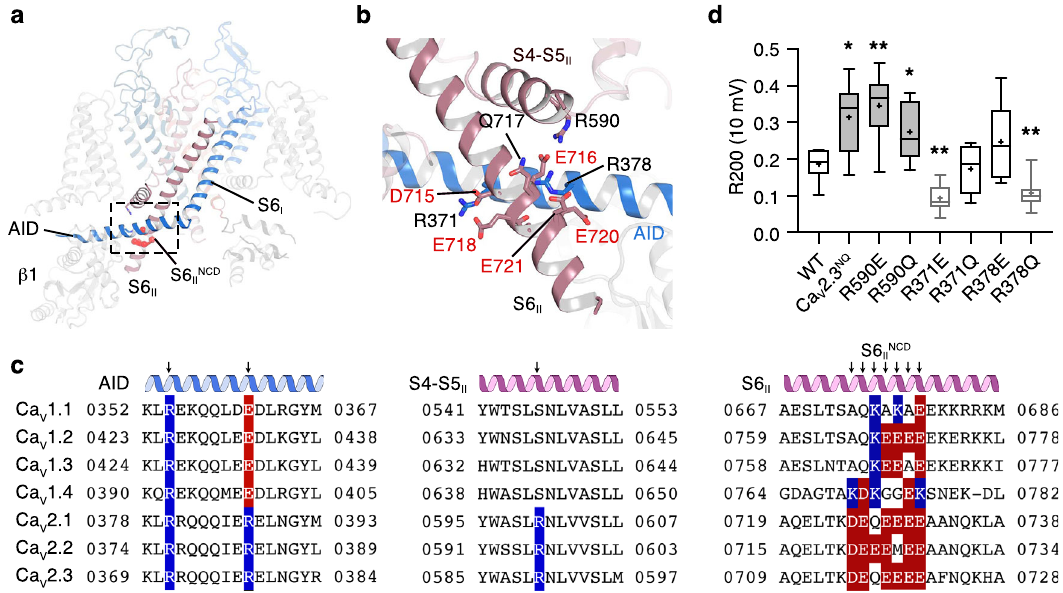
Fig. 5 | Modulation of open-state inactivation. a Interaction of the AID between thenegativelychargeddomainsonS6 II (S6 II NCD )andS4-S5 II .TheCa V 2.3 α 1Esubunit is shownascartoon. The S6 II NCD isoverlaid asredspheres. b Zoomed-inview of the side-chaininteractionsamong S6 II NCD , AID, and S4-S5 II . The S6 II NCD ( 715 DEQEEEE 721 )is shownassticks.ResiduesinvolvedinchargeinteractionsonAIDandS4-S5 II arealso shownassticks.NegativelychargedresidueswithintheS6 II NCD arehighlightedusing red labels. c Sequence alignment of the interaction sites among Ca V 1 and Ca V 2 members. Secondary structures are labeled over the sequences. Mutation sites are indicated by arrows. Residues with positively- and negatively charged sidechains are highlighted by blue and red, respectively. d Ratio of open-state inactivation